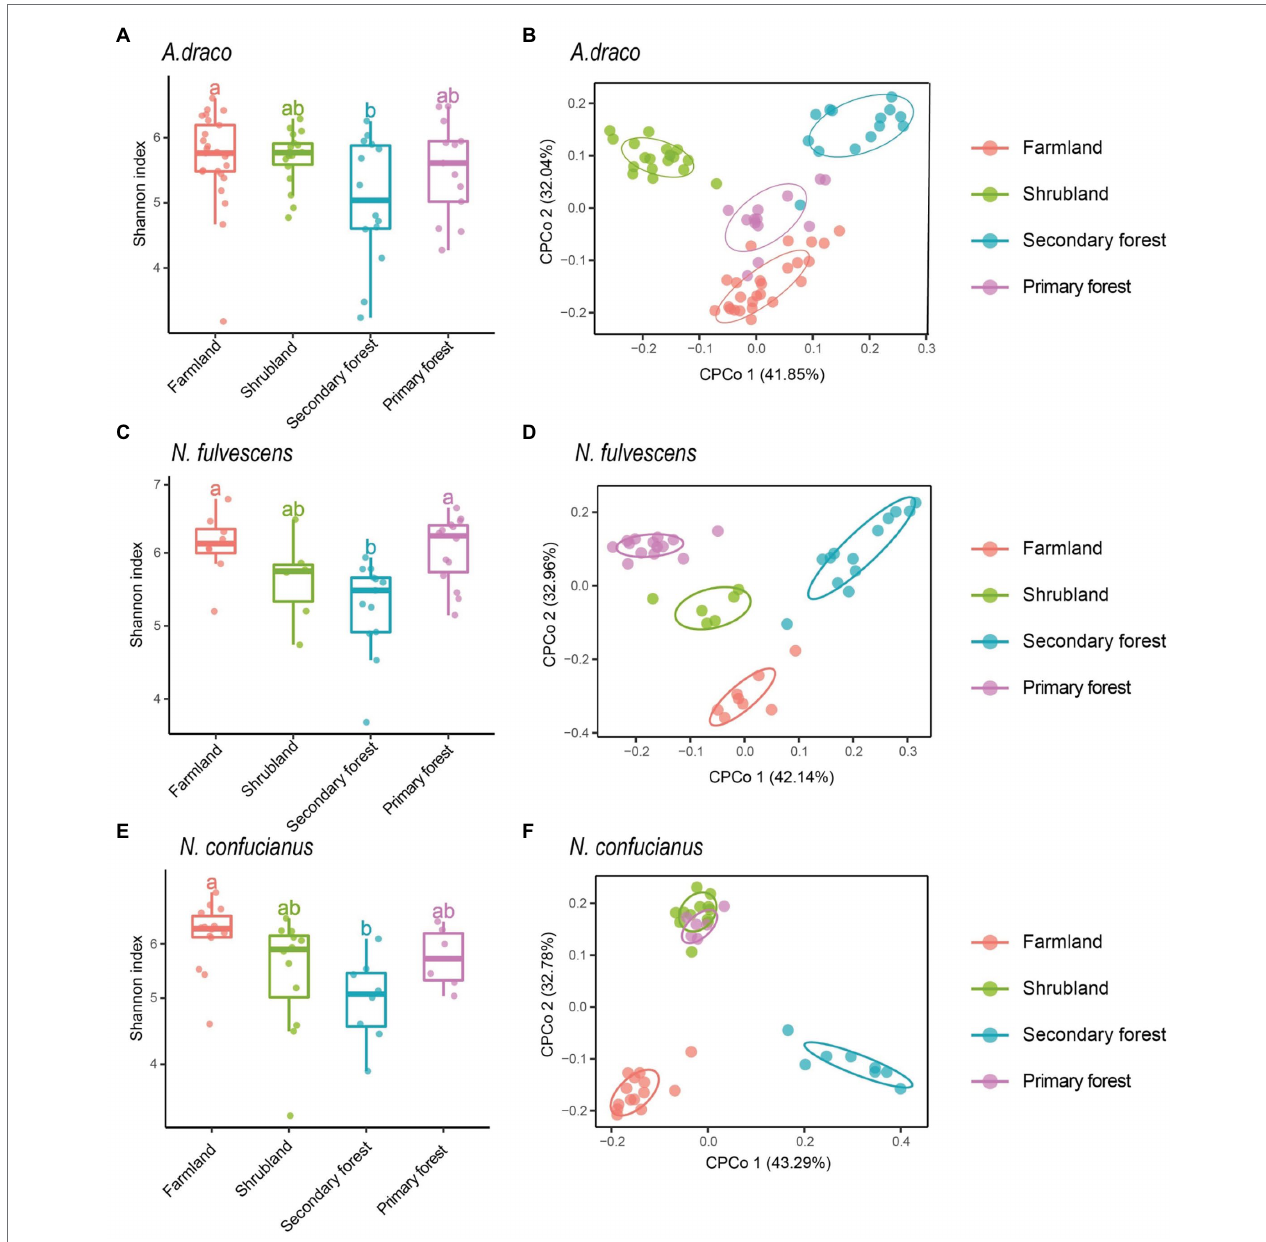
FIGURE 3 | Variation of gut microbial diversity of three rodent species in four different habitats. Alpha diversity (Shannon index) of bacterial communities of Apodemus draco (A) , Niviventer fulvescens (C) , and Niviventer confucianus (E) across four kinds of habitats. Different letters represent statistical significance ( p < 0.05). Beta diversity comparisons of the gut microbiota of A. draco (B) , N. fulvescens (D) , and N. confucianus (F) in four habitat types. The first two axes are shown with constrained CPCoA based on the Bray–Curtis dissimilarity matrix at the ASV